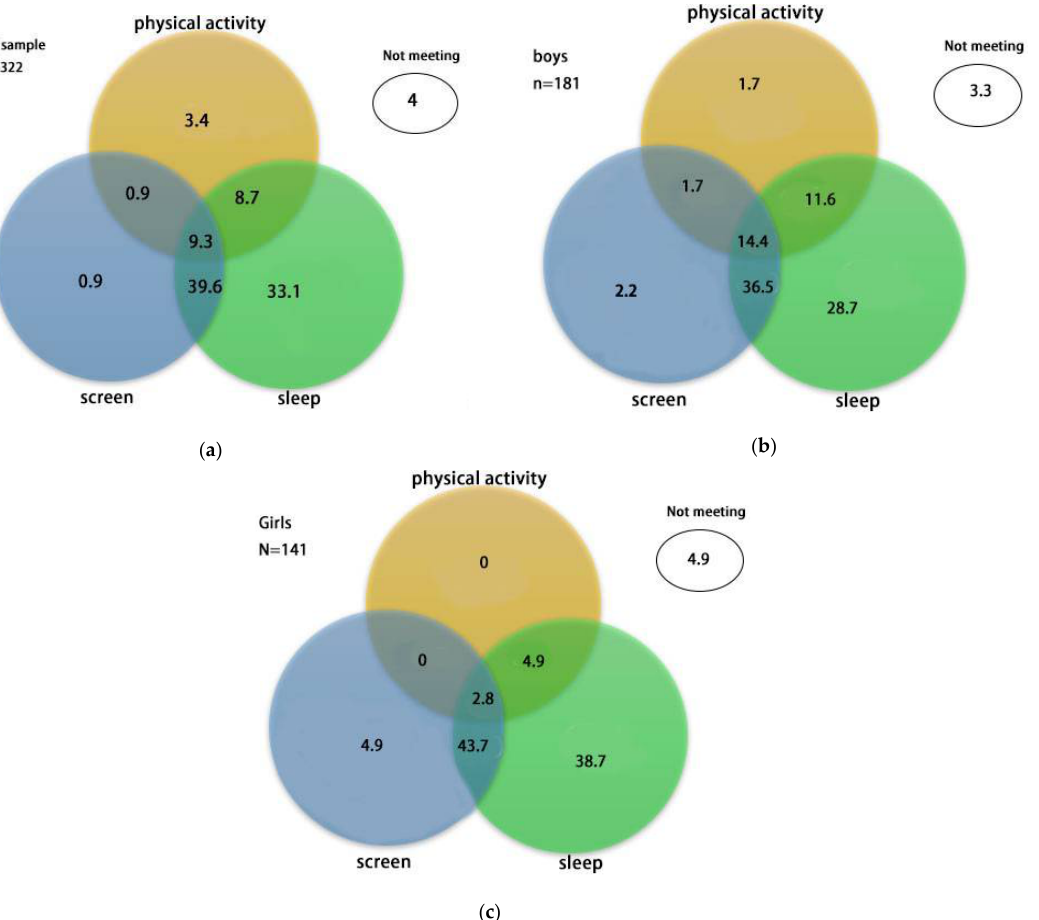
Figure 1. Venn diagram showing the proportion (%) of participants meeting 24-Hour Movement Guidelines separately and in all possible combinations. The sum of each circle is equivalent to the % meeting each individual recommendation (i.e., 22.3% for physical activity, 90.7% for sleep, 50.7% for ST, 4% for non-compliance in the full study sample). ( a ) Venn diagram for all the sample. ( b ) Venn diagram for boys. ( c ) Venn diagram for girls. Table 3. Meeting of 24-Hour Movement Guidelines among preschoolers’ boys and girls.